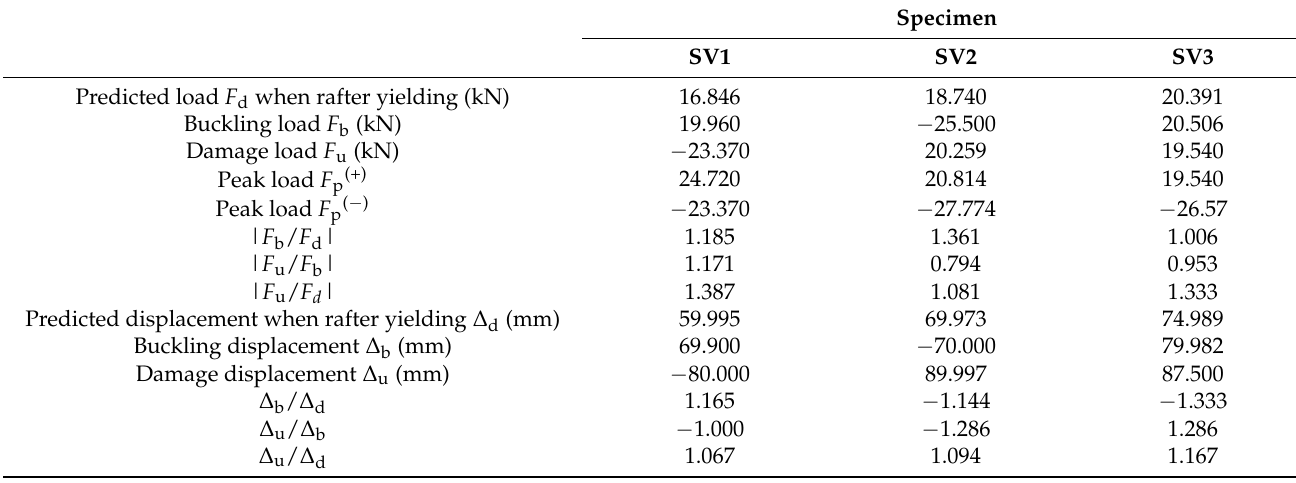
Figure 12. The calculation process of SGF. ( a ) Calculation sketch of the specimen; ( b ) Mechanical model for yielding load calculation; ( c ) Trial calculated internal force.